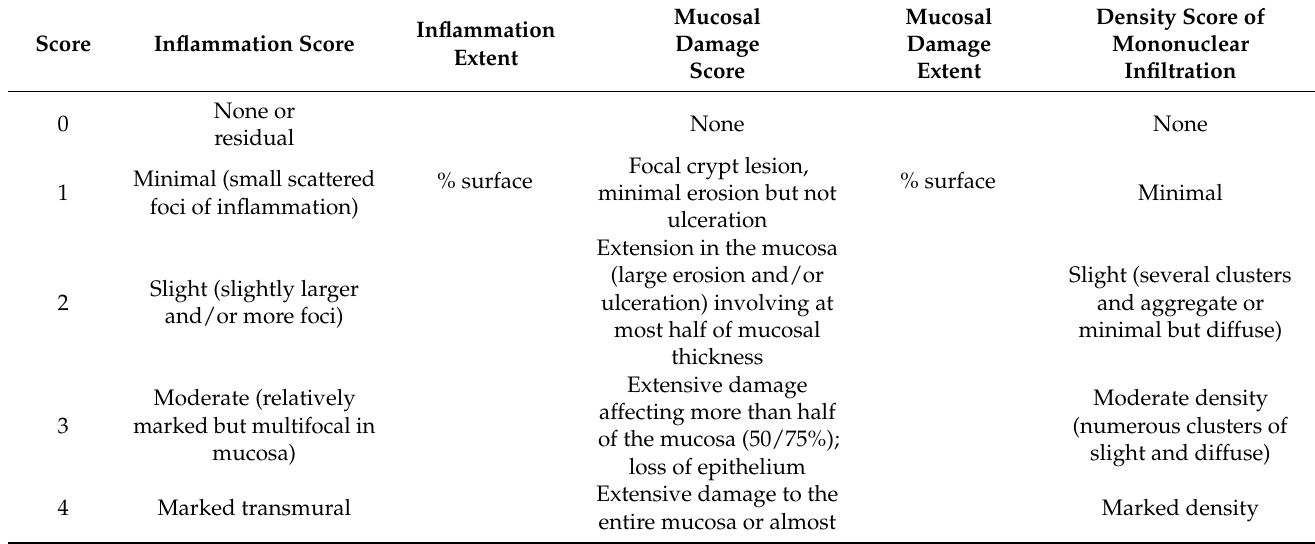
Table 1. Pathology